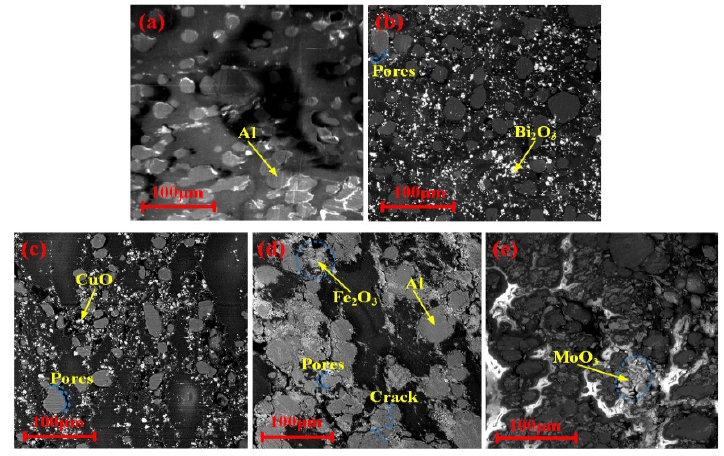
Figure 2. Microscopic characteristics of PTFE/Al/oxides: ( a ) PTFE/Al; ( b ) PTFE/Al/Bi 2 O 3 ; ( c ) PTFE/Al/CuO; ( d ) PTFE/Al/MoO 3 ; ( e ) PTFE/Al/Fe 2 O 3.